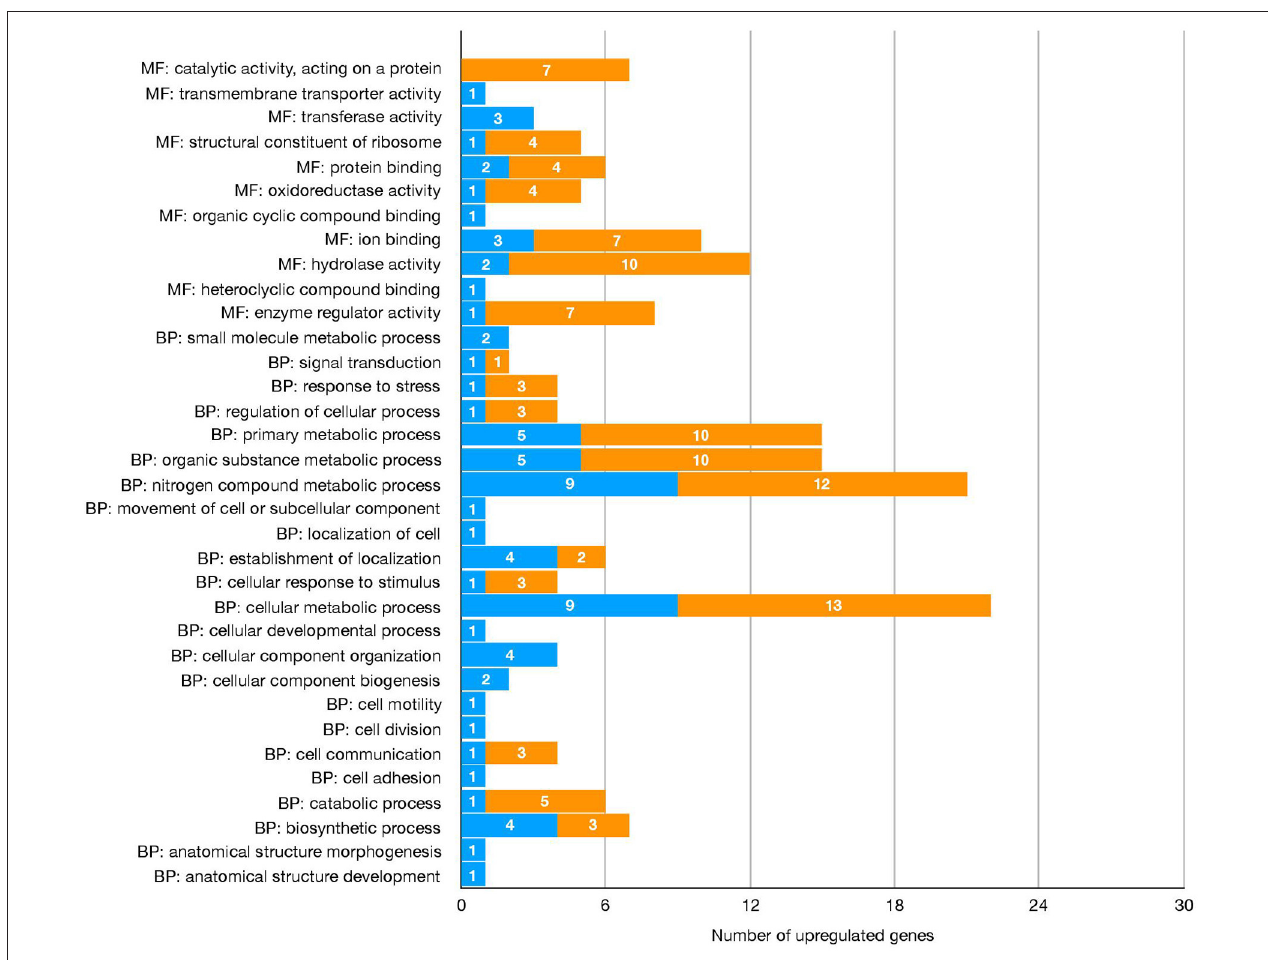
FIGURE 2 | Number of the differentially expressed genes upregulated in salivary glands of R. ( B. ) microplus fed on Holstein (susceptible) and crossbreed (resistant) cattle, based on GO categories Molecular function (MF) and Biological process